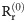
Analysis of multi-modal genomic data using the univariate and bivariate combinatorial Laplacian scores.(a) The 0-dimensional Laplacian score was utilized to identify genes that are differentially expressed across spatial directions in a section of the murine somatosensory cortex using single-molecule FISH data. Gene expression levels were evaluated using the combinatorial Laplacian score based on the spatial dimensions. Genes with low Rr(0) have significant spatial patterns of expression. For reference, the expression patterns of two genes with low Rr(0) (Lamp5 and Kcnip2) and two genes with high Rr(0) (Ttr and Pdgfra) are shown. Cells are represented by means of a Voronoi tessellation and are color-coded according to the expression level of the gene (blue: low; red: high). (b) Analysis of spatial relations among cell populations using the bivariate combinatorial Laplacian score. The 0-dimensional bivariate combinatorial Laplacian score was computed for each pair of cell populations in the murine somatosensory cortex dataset using the spatial dimensions to build the Vietoris-Rips simplicial complex. The significance of the score was estimated for each pair of cell populations by randomization and is shown in the heatmap. Cells from pairs of populations that have a significant score often appear adjacent to each other in the spatial dimensions. (c) Analysis of whole exome and mRNA sequencing data of 667 low-grade glioma and glioblastoma tumors of The Cancer Genome Atlas (TCGA) using the 0-dimensional Laplacian score. A Vietoris-Rips complex was built based on the gene expression data. Binary vectors indicating whether a gene is non-synonymously mutated or not were taken as features. The 0-dimensional Laplacian score identifies genes for which their mutation is associated with consistent global expression patterns. A UMAP representation based on the expression data is shown for some representative genes with low (IDH1, EGFR, and RB1) or high (ACAN) value of Rr(0), color-coded according to the somatic mutation status of the gene (orange: non-synonymously mutated; grey: non-mutated or synonymously mutated).